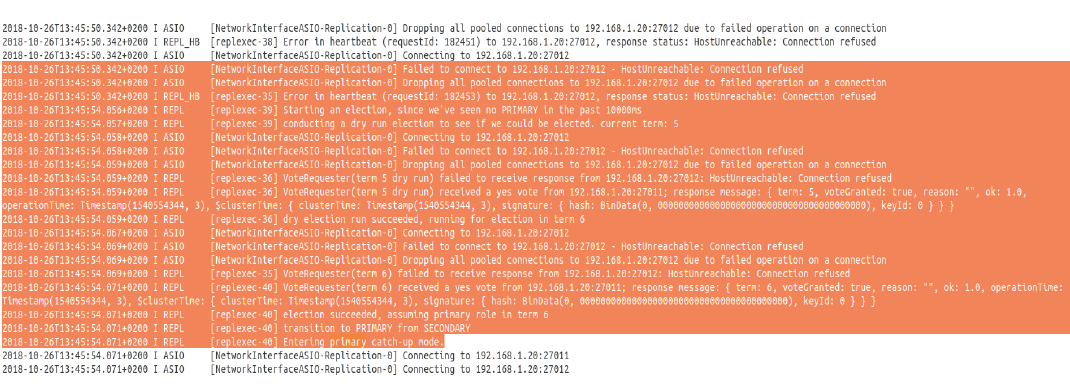
Figure 8. Secondary database log.